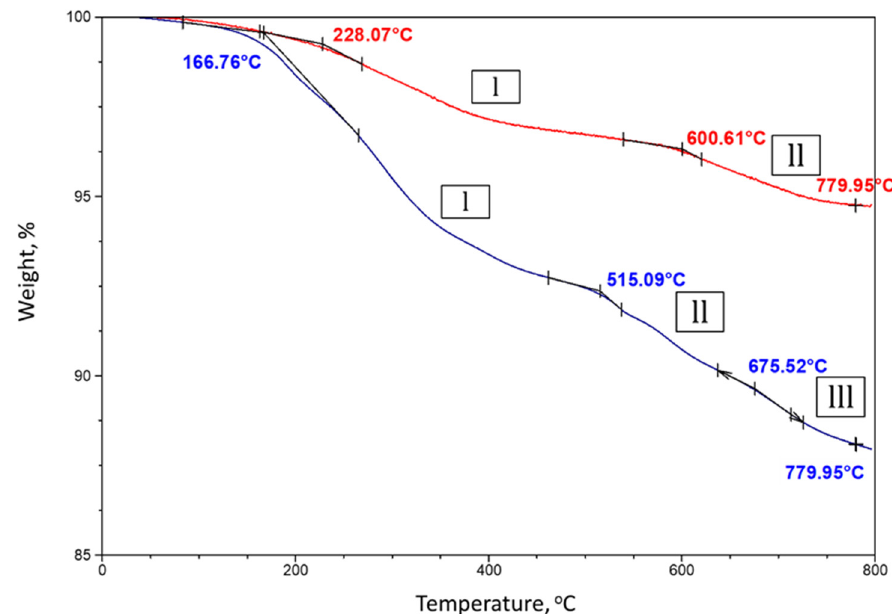
Figure 10. TGA curves of 85°-steam cured and 250 °C-autoclaved PMHS/SMS